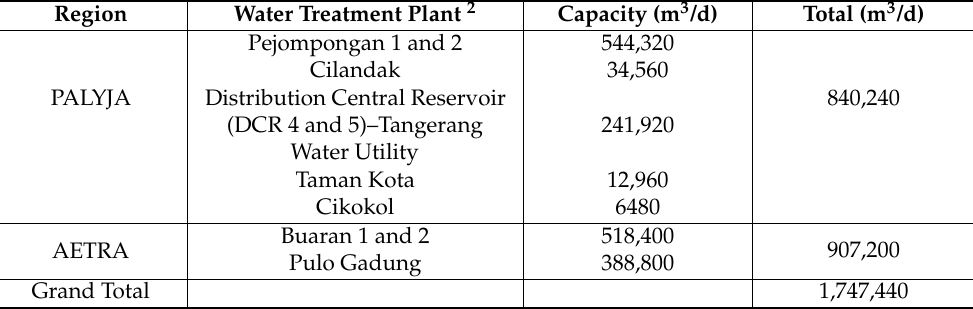
Figure 1. ( a ) Water sources and water treatment plants (modified from PAM Jaya) [15]. ( b ) Water supply areas of the two operators: PALYJA and AETRA (modified from PAM Jaya) [15]. Table 2. Water treatment plants in Jakarta.